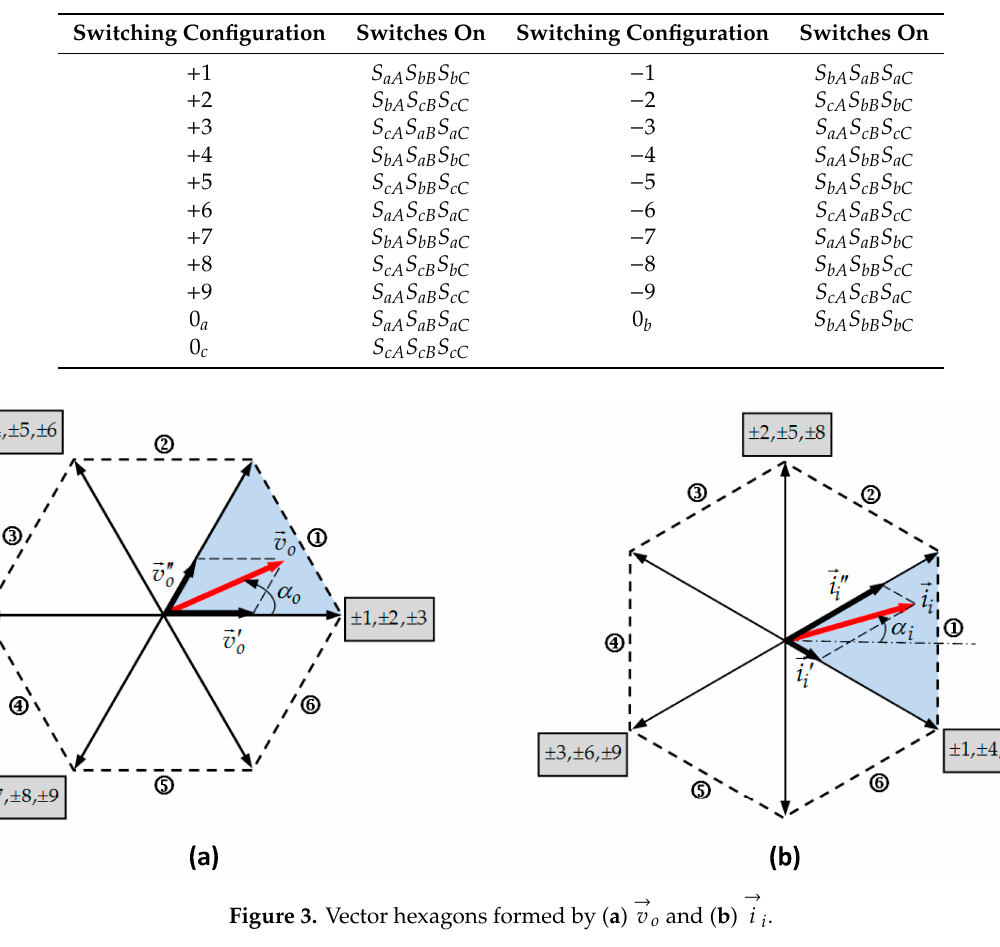
Figure 3. Vector hexagons formed by ( a ) o v